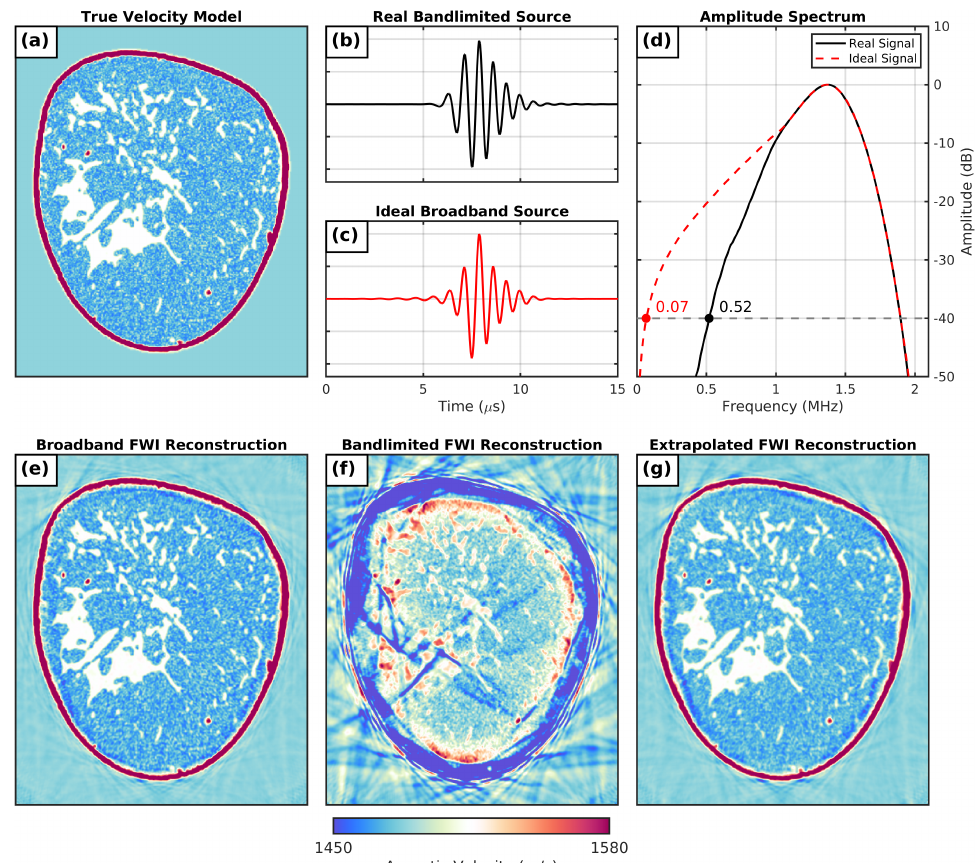
Figure 2. Performance of our 2D U-Net low-frequency extrapolation in FWI. ( a ) Coronal slice of a realistic numerical breast model; ( b ) narrowband source signal extracted from real P4-1 transmission data and ( c ) corresponding ideal broadband source signal; ( d ) amplitude spectrum of real and ideal source signals; ( e ) full-waveform inversion of broadband ultrasound data using ideal source signal; ( f ) full-waveform inversion of bandlimited ultrasound data using real source signal; ( g ) full-waveform inversion of narrow-band ultrasound data after being fed through a low-frequency extrapolation